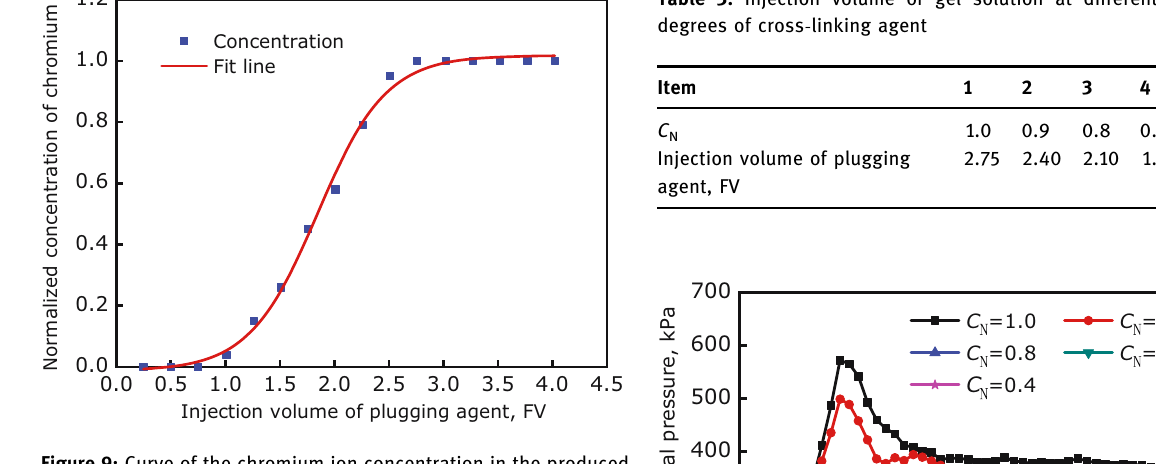
Figure 9: Curve of the chromium ion concentration in the produced fl uid at fracture outlet vs the injection volume of the gel plugging agent.